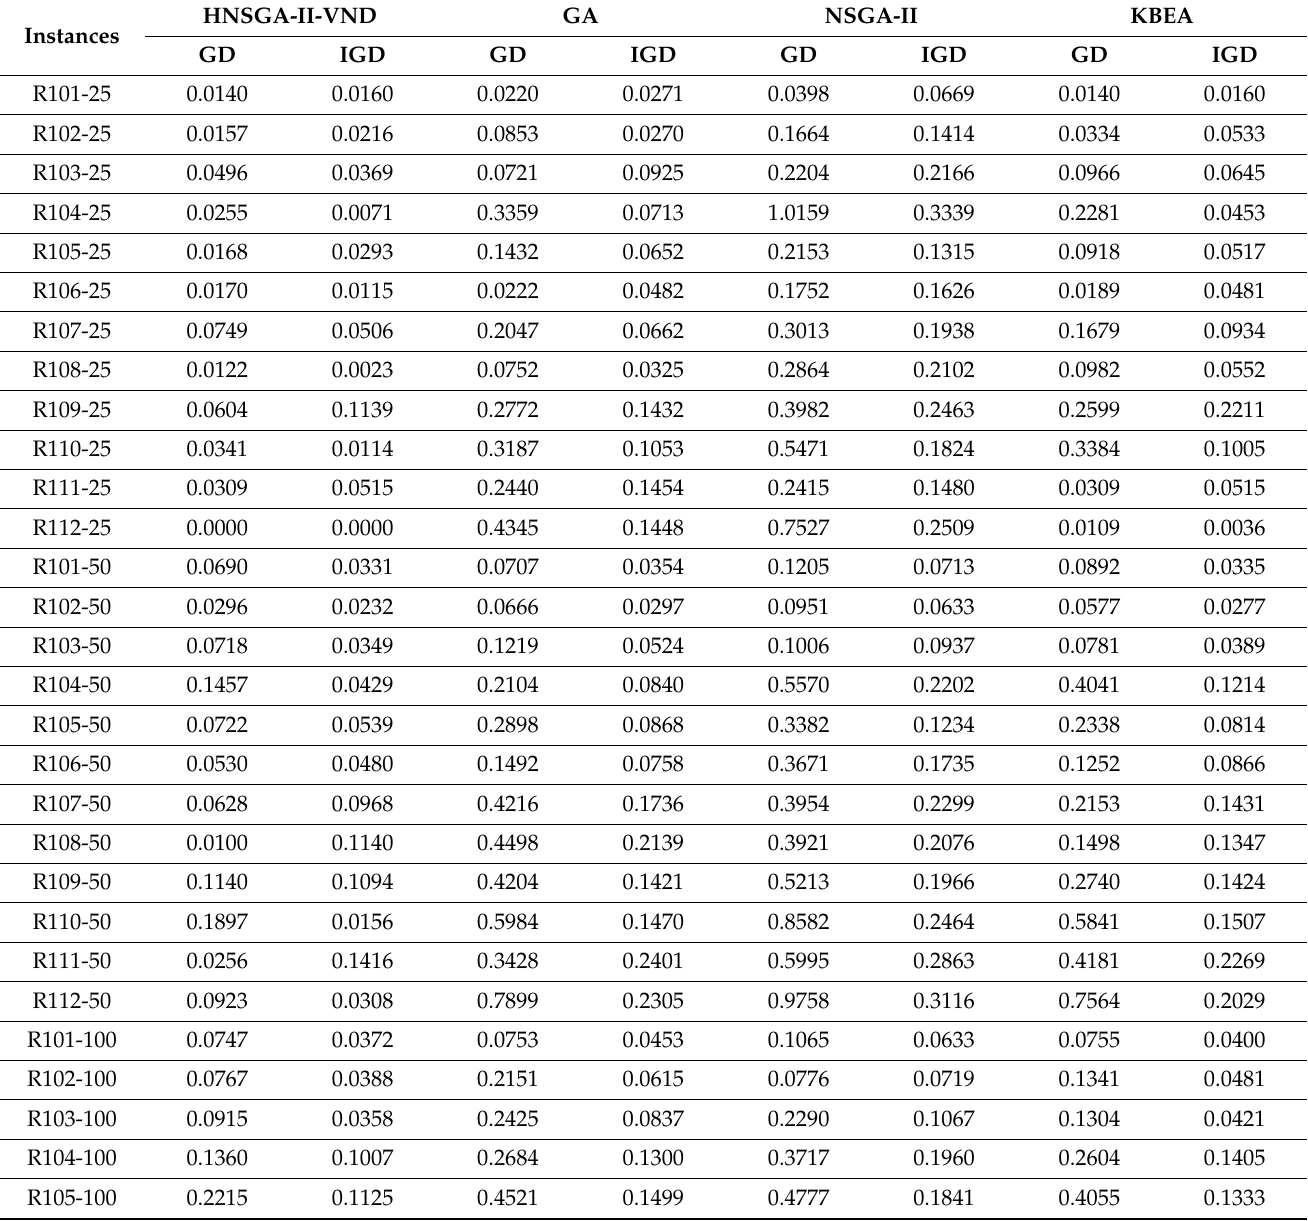
Table 7. The index values of all comparison algorithms in R